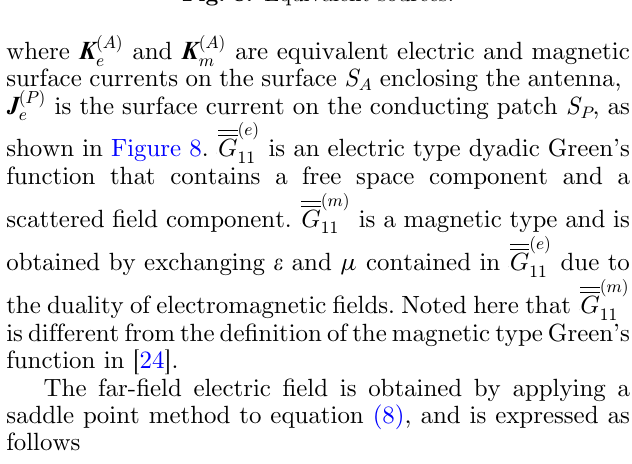
Fig. 9. Radiation patterns of half-wavelength dipole antenna at 10 GHz in z – x plane ( h = l /4)